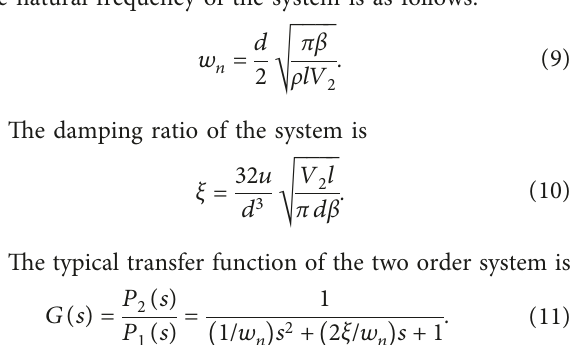
Figure 2: Mathematical model of the hydraulic